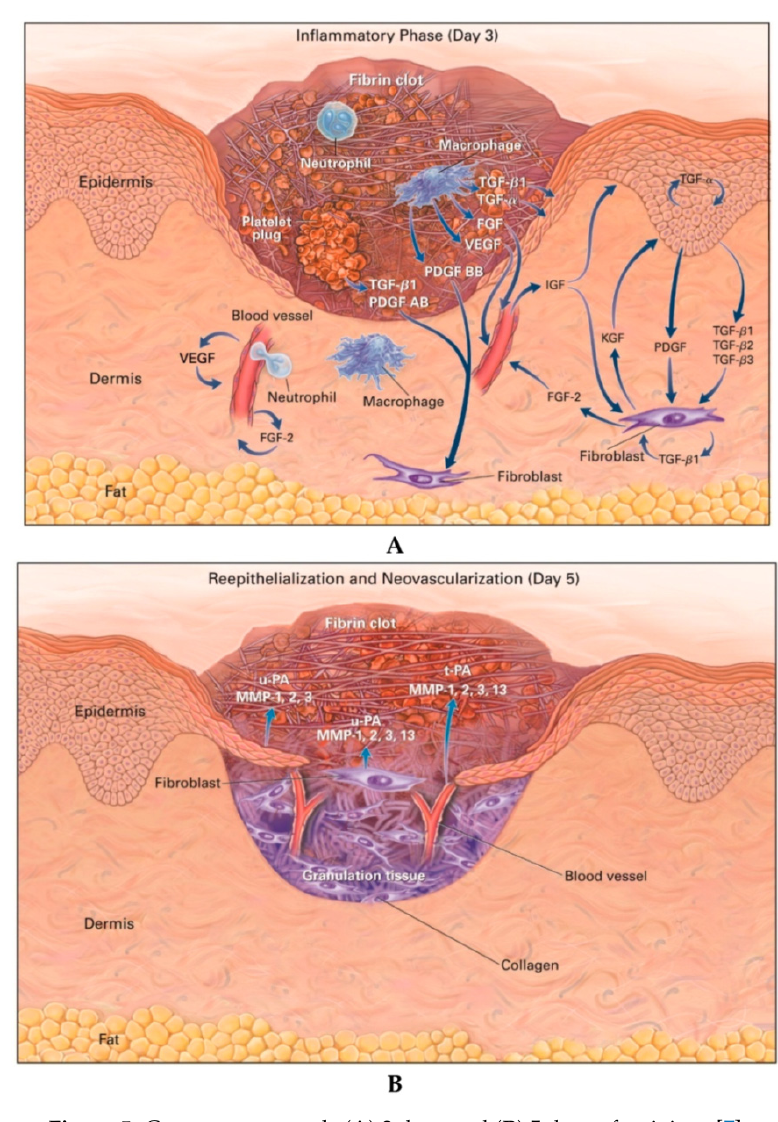
Figure 5. Cutaneous wounds ( A ) 3 days and ( B ) 5 days after injury [7].